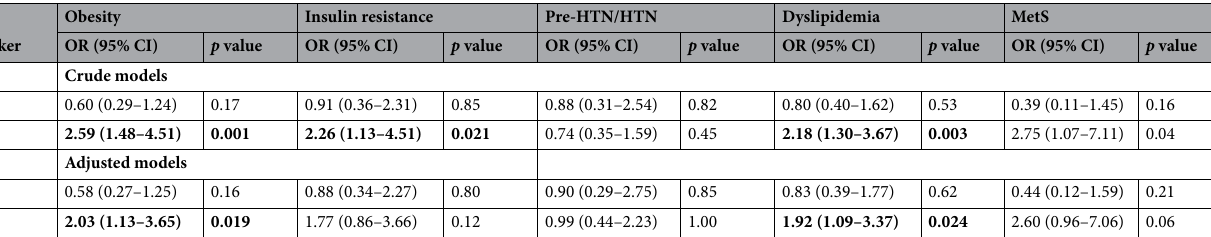
Table 5. Associations between biomarkers of endotoxemia and cardiometabolic complications in survivors of childhood acute lymphoblastic leukemia: crude and adjusted models. The crude and adjusted models were assessed between each biomarker and each cardiometabolic outcome. Models were adjusted for CRT exposure, age at diagnosis, time since diagnosis and sex. Odds ratio (non-corrected 95% CI) and p-value are indicated for each association. Significant associations are in boldface. Bonferroni-adjusted alpha = 0.05/ number of biomarkers = 0.05/2 = 0.025. Metabolic syndrome was defined according to the International